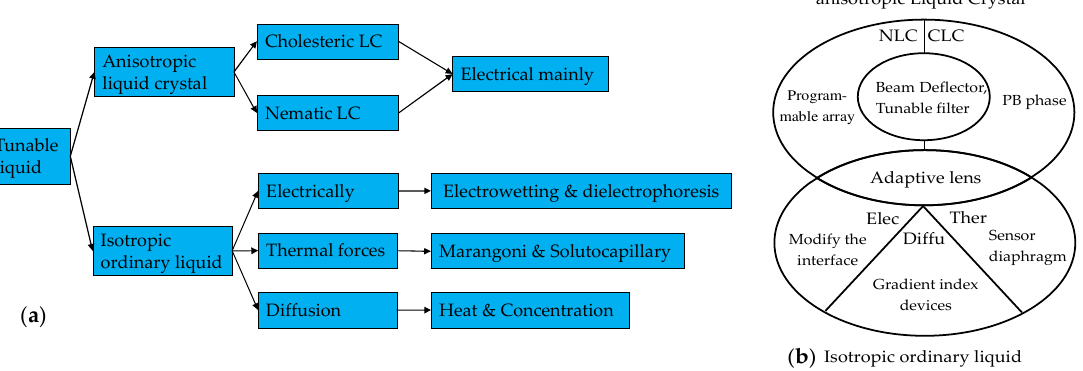
Figure 1. A brief introduction of the tunable liquid devices’ ( a ) working principle and ( b ) a diagram that presents the common and unique device type.